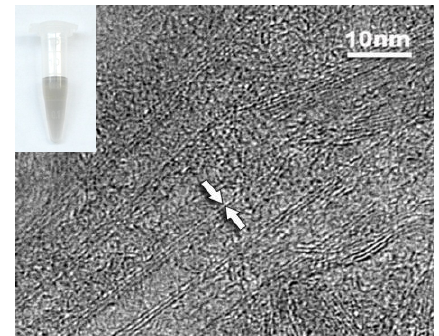
Figure 2. A typical transmission electron microscope image of SWCNTs and a photography of SWCNTs solution (inset).